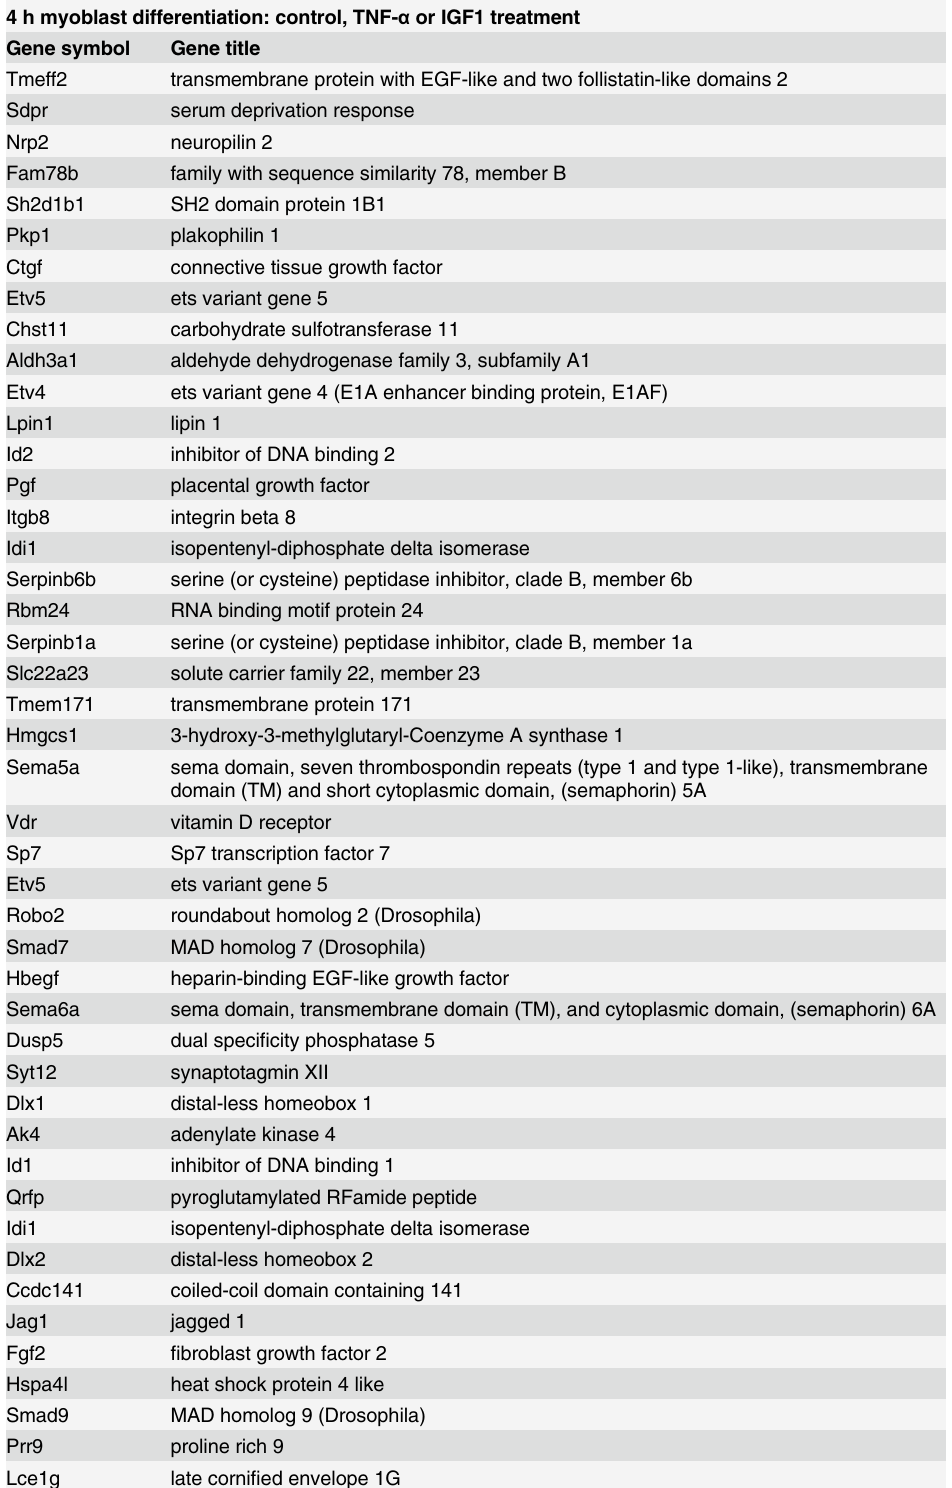
Table 2. Genes describing the treatment effects. 4 h myoblast differentiation: control, TNF- α or IGF1